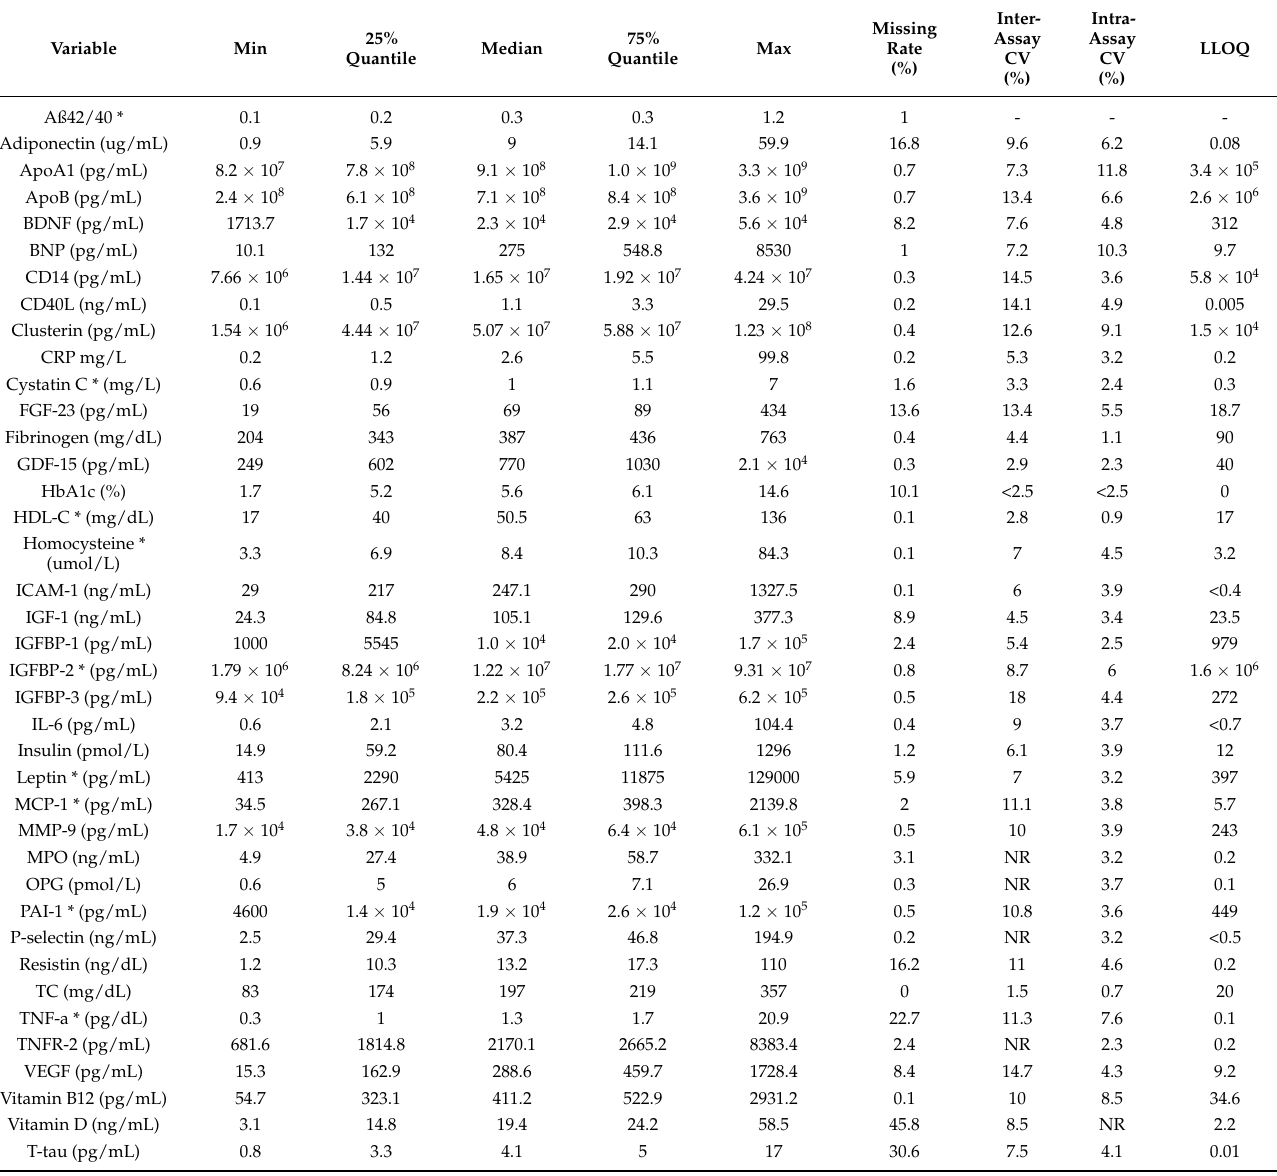
Table 1. List of blood-based biomarkers with assay performance